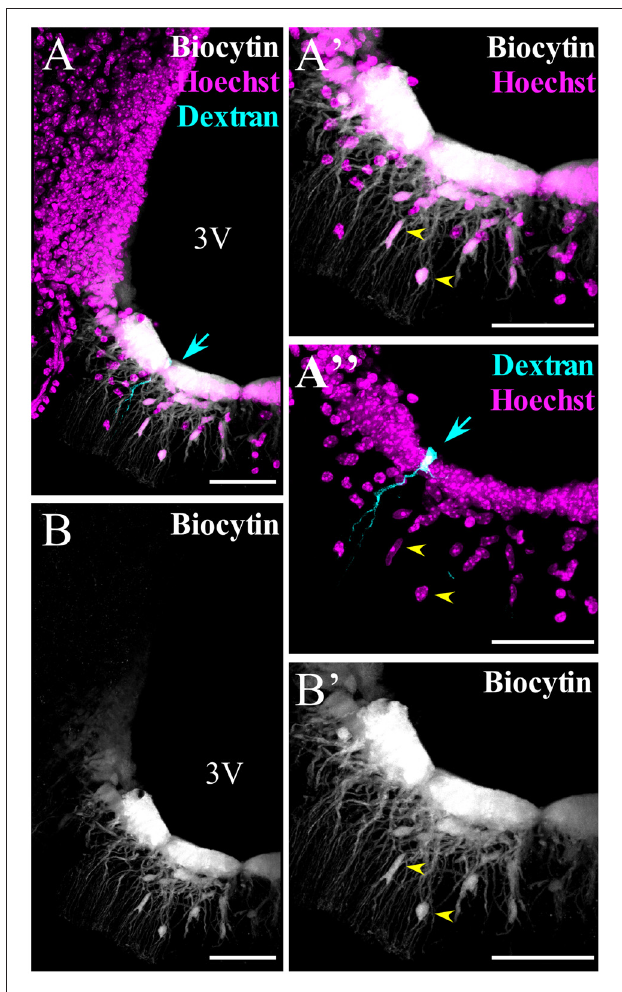
FIGURE 4 | β -tanycytes are also highly coupled with each other and with parenchymal cells. (A–B (cid:48) ) Spread of biocytin through β -tanycytes and parenchymal cells. (A (cid:48) ,A (cid:48)(cid:48) ,B (cid:48) ) Higher magnification of the median eminence (ME) portion, where β -tanycytes localize. (A,A (cid:48)(cid:48) ) To identify the cell that was initially patched, it was filled with dextran Texas red (3 kDa, cyan arrow). Yellow arrows in (A (cid:48) ,A (cid:48)(cid:48) ,B (cid:48) ) show the parenchymal cells coupled. 3V, third ventricle. Scale bar: 50 µ